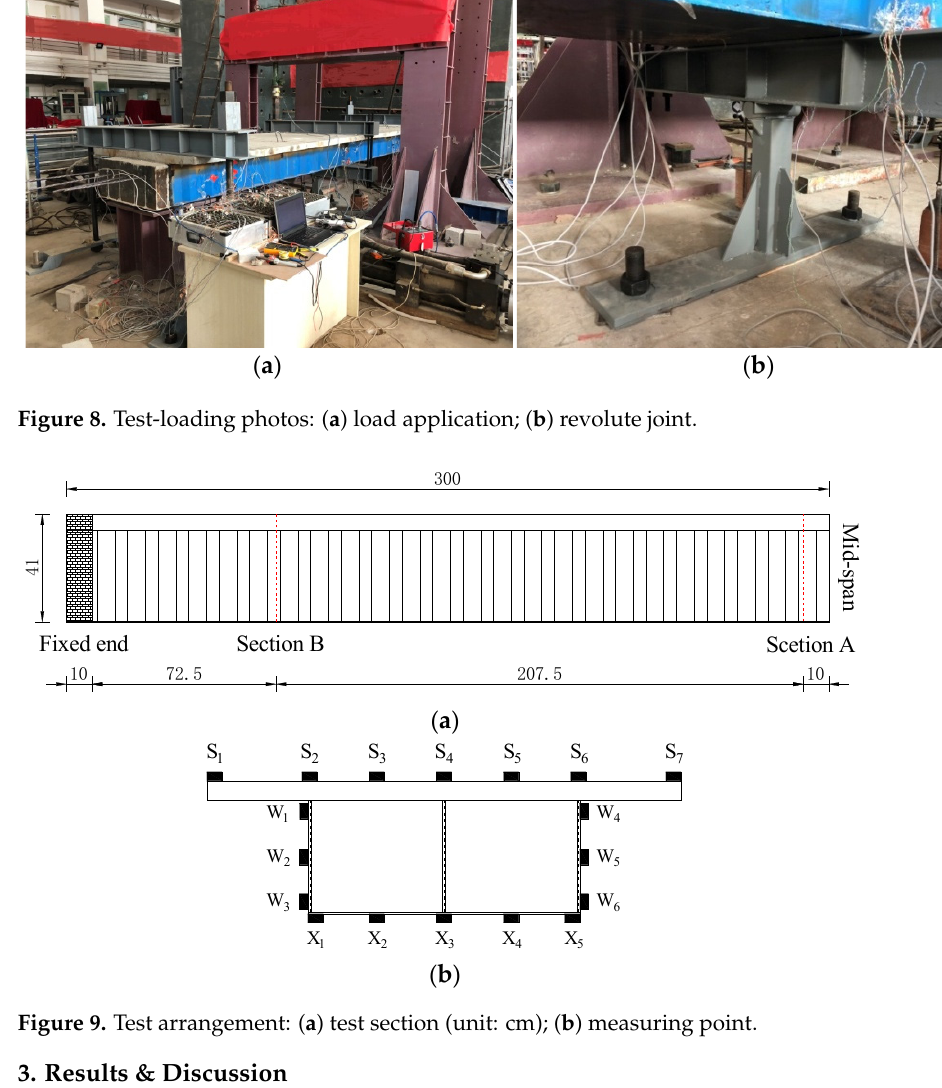
Figure 8. Test-loading photos: ( a ) load application; ( b ) revolute joint.